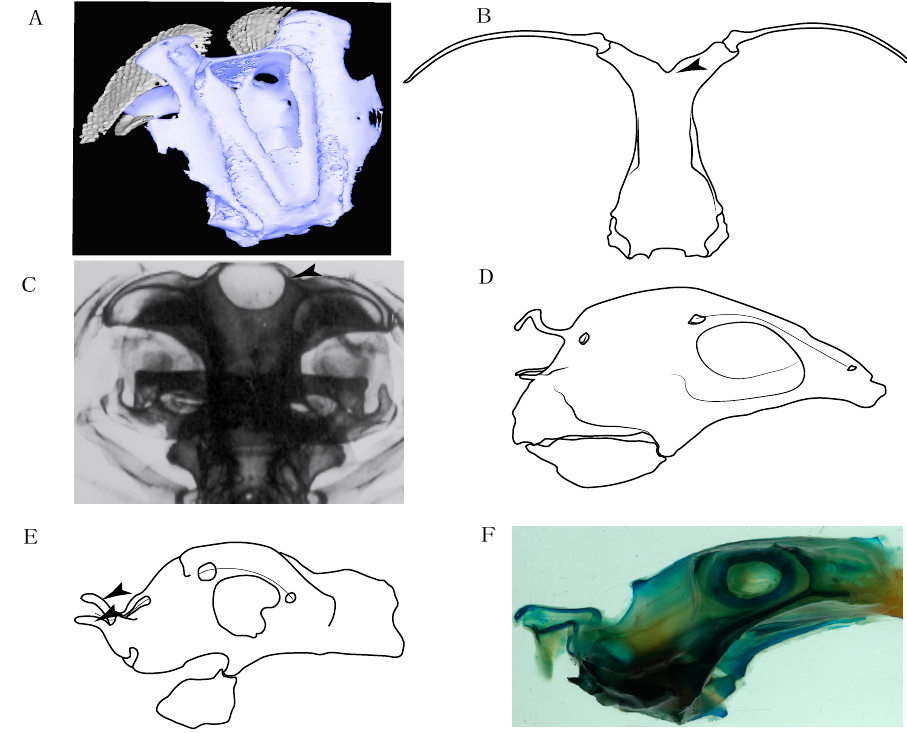
Figure 6. Variation on the development of rostral cartilages among selected chondrichthyan groups. State (0) ( A ) Rhinoptera bonansus (GMBL 73 https://sharksrays.org/ (accessed on 23 February 2020) and ( B ) Hypnos monopterygius (USNM 84374 https://sharksrays.org/ (accessed on 23 February 2020)). State (1) ( C ) Zanobatus sp. (MNHN 1989.12.91); Inapplicable (-) ( D ) Chimaera cubana (USNM 400700 https://sharksrays.org/ (accessed on 23 February 2020)) and ( E , F ) Callorhinchus capensis (AMNH 36943); Arrowheads indicate the lateral rostral process and medial rostral process in Holocephali, in Zanobatus the arrowhead the medial growth, and in Hypnos the medial region.